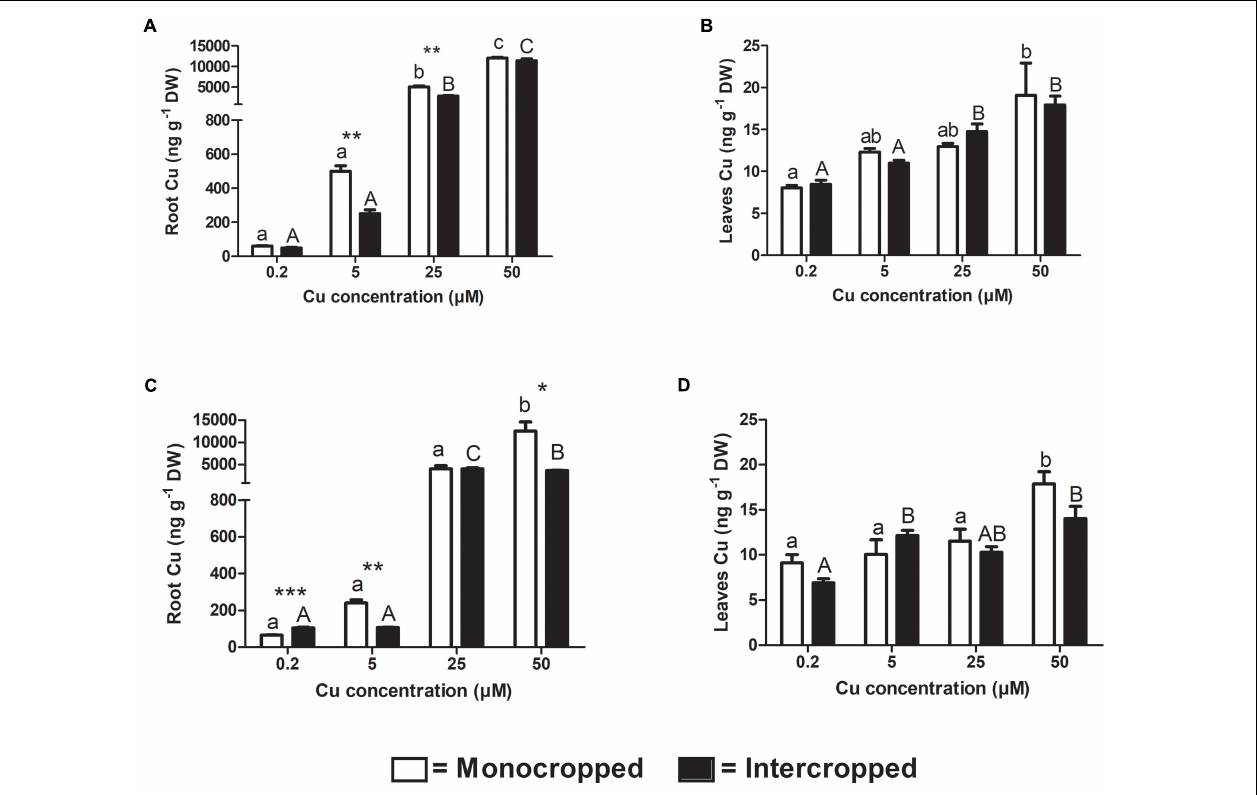
FIGURE 5 | Analyses of Cu concentration in grapevine plant tissues. Copper concentration detected in roots (A) and leaves (B) of both mono- and intercropped Fercal rootstock plants, and in roots (C) and leaves (D) of both mono- and intercropped 196.17 rootstock plants. The data are reported as means ± SE of three biological replicates. Different letters indicate significantly different values as determined using one-way ANOVA with Tukey post hoc tests ( p < 0.05). Lower case letters indicate the statistical significance for monocropped plants in the different Cu concentrations, whilst upper case letters indicate the statistical significance for intercropped plants grown in the different Cu concentrations. Stars indicate the significance (Student’s t -test) between the Cu concentrations detected in mono- and intercropped rootstock plants ( ∗ p < 0.05; ∗∗ p < 0.01; ∗∗∗ p <